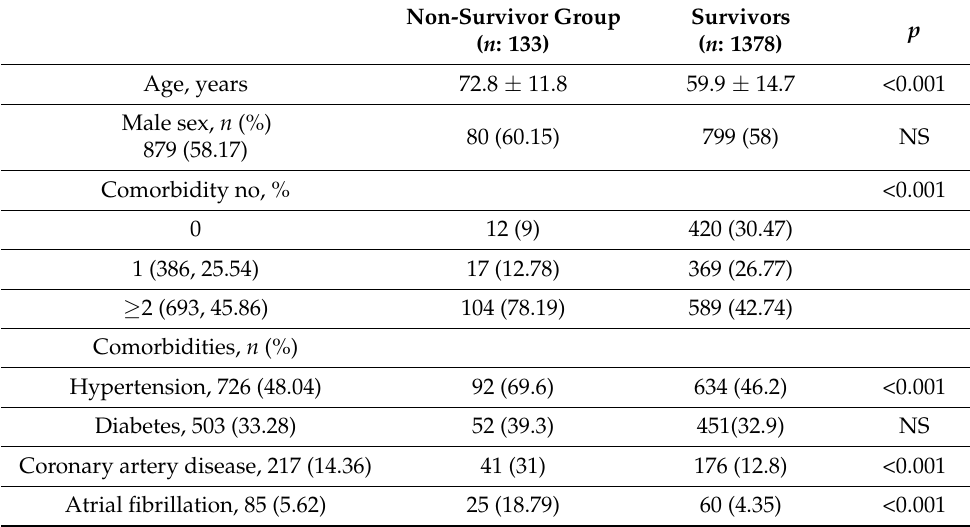
Table 1. The baseline characteristics of the